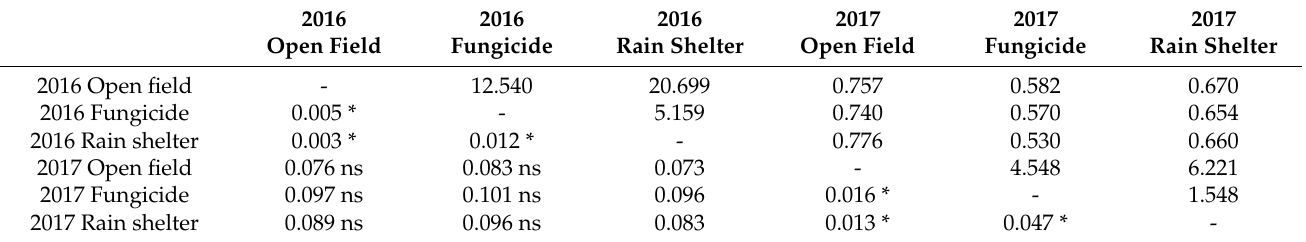
* significant correlations at the 5% confidence level; ns, no significant correlations at the 0.05